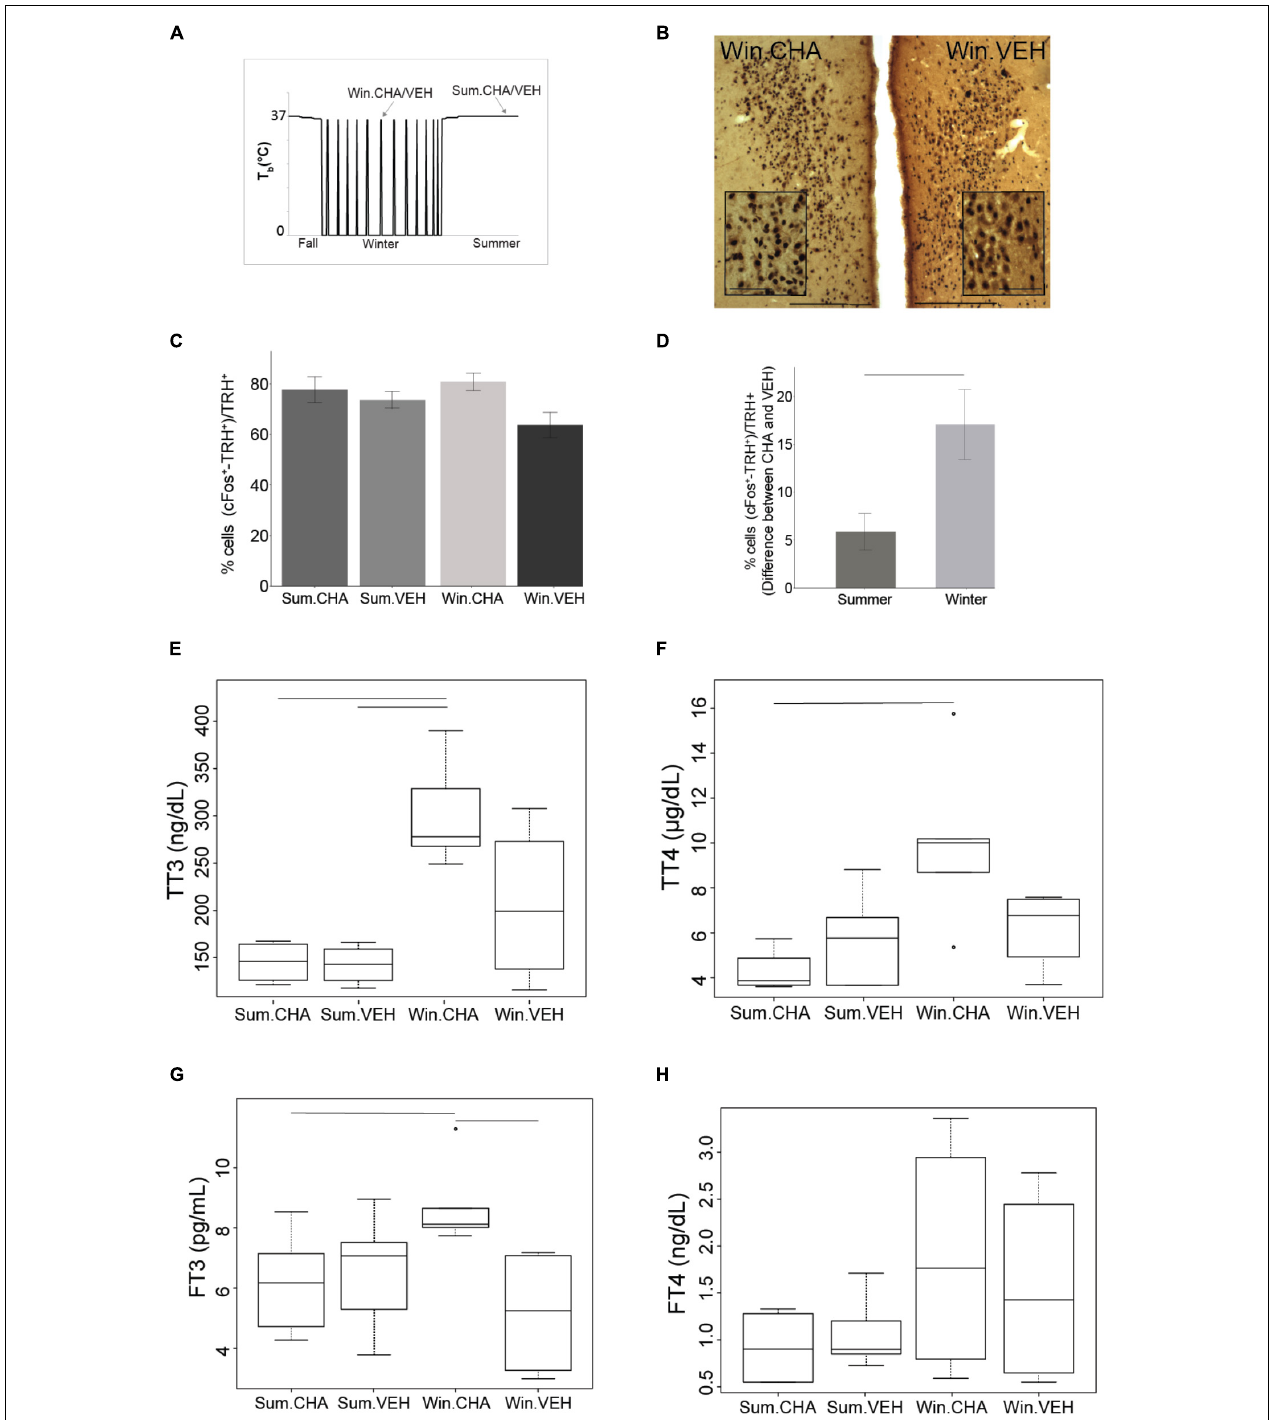
FIGURE 3 | CHA activates HPT axis more in winter than in summer. Results from samples collected at times shown in (A) . Photomicrographs of double stained brain sections in (B) , TRH neurons (brown) and cFos (black) in the PVN are shown in VEH and CHA animal, the insert in PVN images show higher magnification area, scale bar 200 µ m (lower magnification), scale bar 50 µ m (higher magnification). TRH neurons are activated after CHA with no effect of season (C) . Significantly higher activation of TRH neurons after CHA in Winter compared to Summer was evident when AGS were matched for age and gender. Data shown are mean ± SEM of differences between CHA and vehicle-treated pairs matched for age and gender (D) . CHA increases TT3 and TT4 more in Winter than in Summer (E,F) , FT3 increases after CHA in Winter (G) . FT4 does not change after CHA (H) . Symbols in (F,G) represent outliers. Horizontal bars represent differences between groups, p < 0.05, Wilcoxon’s rank-sum test in (E , F) , t -test in (C,D,G) , n = 4–7.